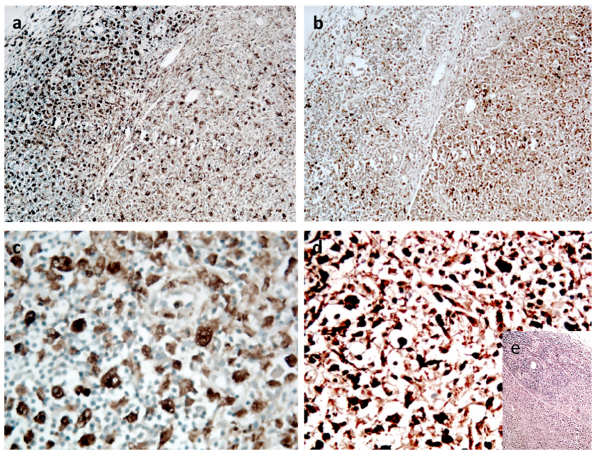
Figure 2. Node section: ( a ) CD68- and ( b ) lysozyme-positive cells (magnification, ×20). Details of cell cytology at ×40. In ( c ) CD68 and in ( d ) lysozyme. In ( e ), insert of H&E: subcapsular area with distorted structure and loss of germinal centres (×10 magnification) (DAB Substrate-Chromogen system).